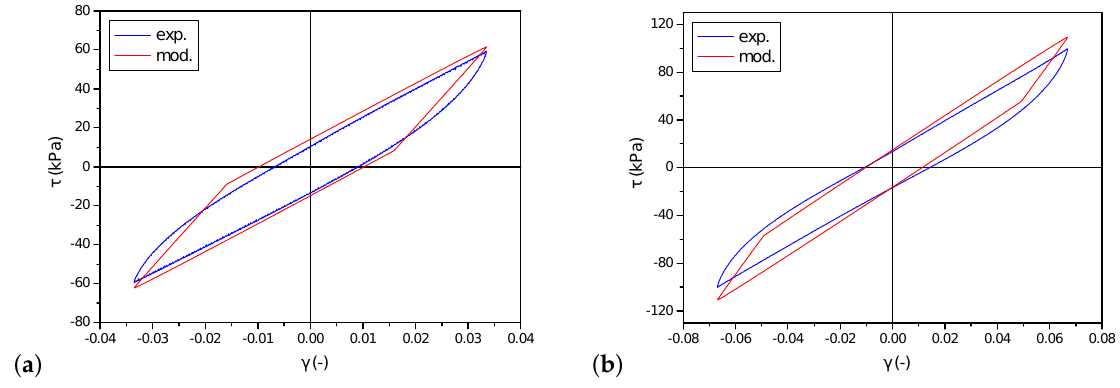
Figure 9. Direct comparison of experimental and model results. Selected hysteresis loops for two different values of strain amplitude: ( a ) γ A = 0.035; ( b ) γ A = 0.067